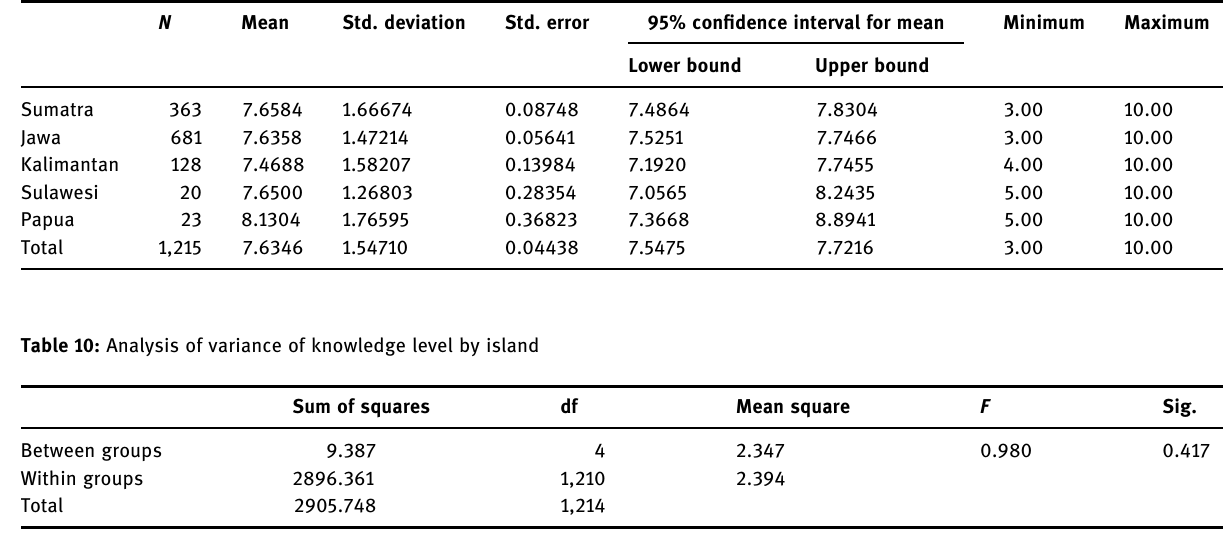
Table 9: Descriptive of knowledge level by island N